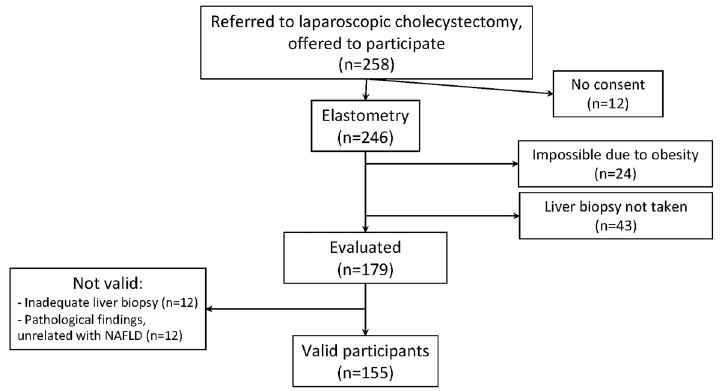
Figure 1. Disposition of patients.